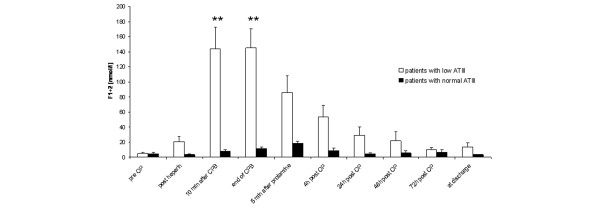
Correlation between antithrombin III (AT III) values and prothrombin fragment 1+2 (F1+2). Patients with normal AT III levels show almost no F1+2 production in the peri- and postoperative courses. During cardiopulmonary bypass (CPB), low AT III correlates with high F1+2: **p < 0.01. post OP, postoperatively; pre OP, preoperatively.